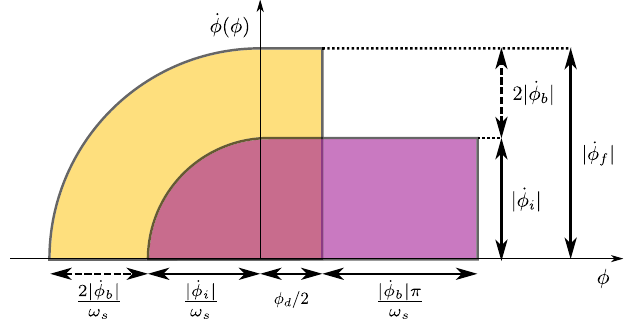
FIG. 2. Diagram of the quarter areas of the phase space before (purple) and after (yellow) a particle reflection off a moving barrier comparing fully filamented cases. The buckets are shifted and centered around the edge of the reflection region for before and after a reflection to allow an easy comparison of the area changes in the reflection region and the drift space. The two trajectories phase spaces are shifted such that the main parameters used in the calculation are